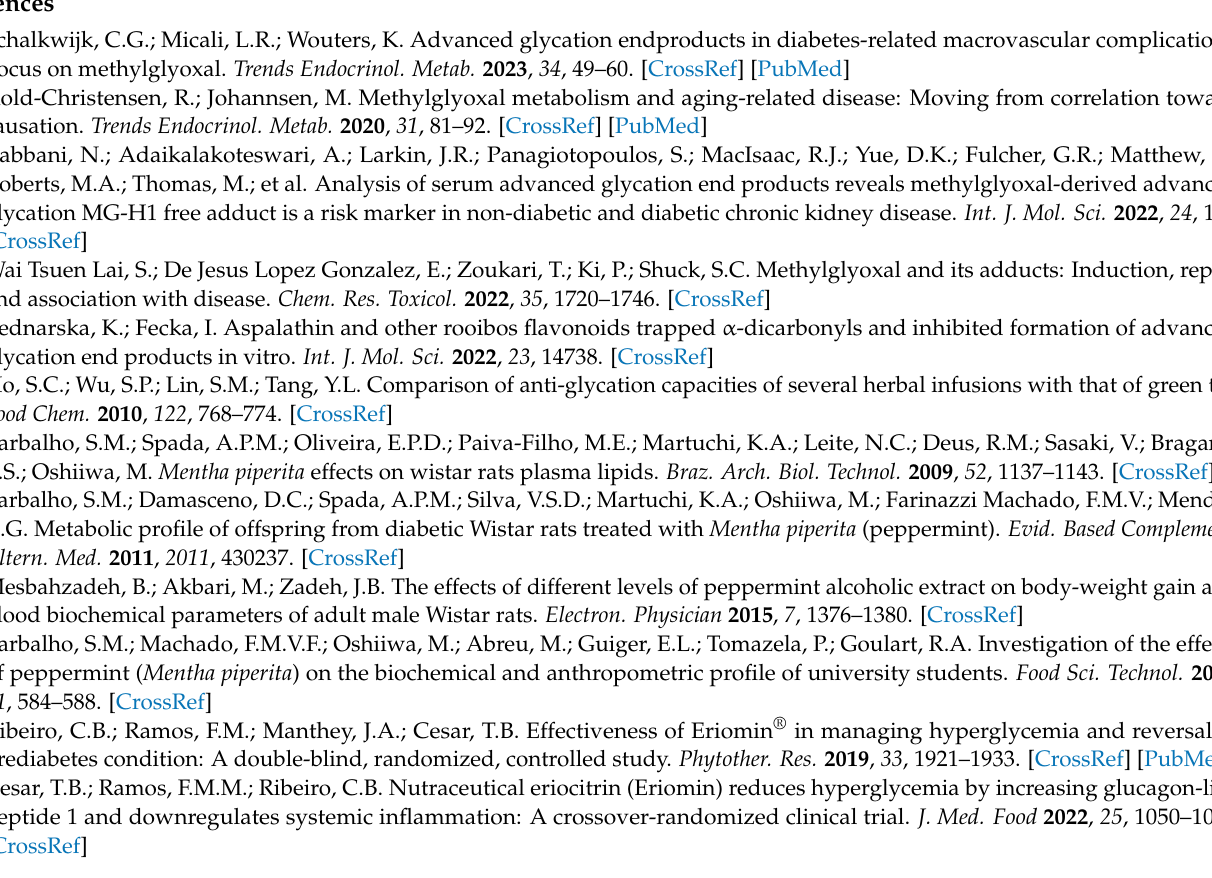
Figure S7. MS spectra of apigenin-MGO mono-adduct 2; Figure S8. MS spectra of